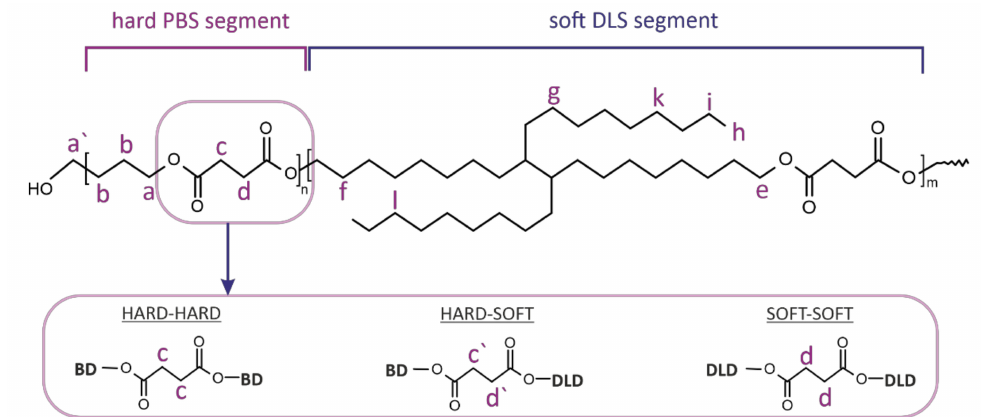
Figure 2. Chemical structure of poly[(butylene succinate)-co-(dilinoleic succinate)] copolyester, with the possible locations of hard and soft